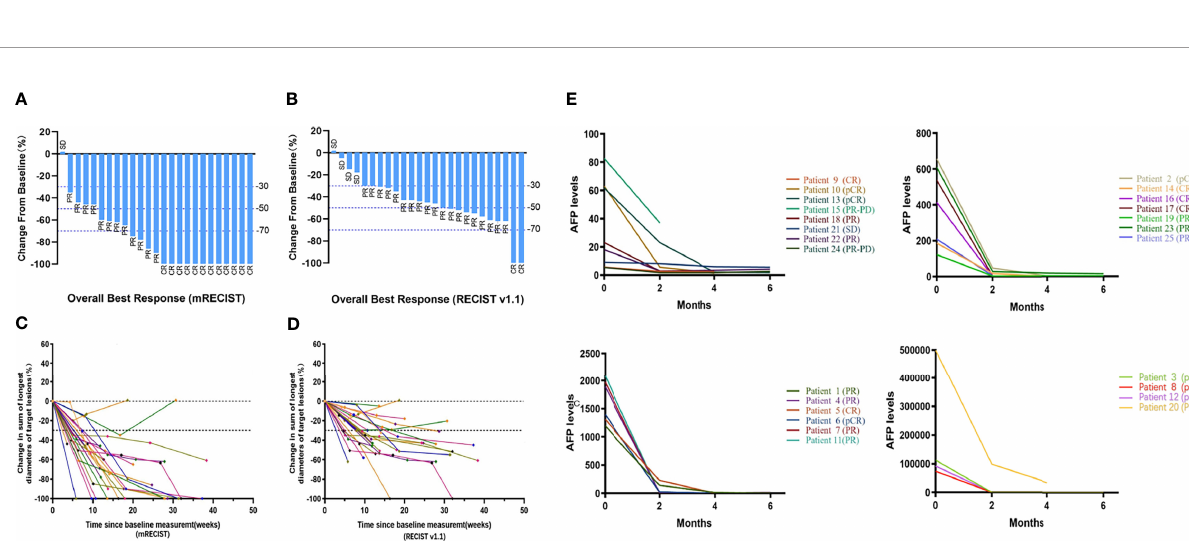
FIGURE 3 | Best percentage change in tumor burden and changes of AFP levels over time. Waterfall plot of best percentage change from baseline in sums of diameters of target lesions by (A) modi fi ed RECIST and (B) RECIST v1.1; Percentage change in target lesions diameters over time by (C) modi fi ed RECIST and (D) RECIST v1.1; (E) AFP levels of 25 patients before treatment, two months, four months and six months after fi rst cycle of treatment, presented with their ef fi cacy outcomes by modi fi ed RECIST,